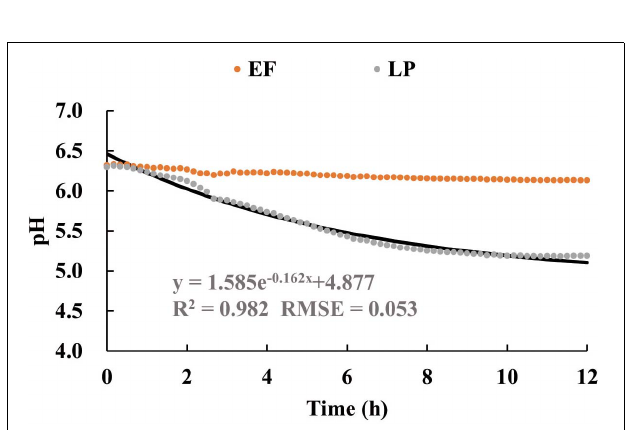
FIGURE 9 | The data decomposition of the time courses of pH in Figure 3A to separate the additional roles of Enterococcus faecium (EF) or Lactiplantibacillus plantarum (LP) to support LB in accelerating the acidification process of the substrate (MRS). The solid line is the regression approximation to the separate data of LP. EF, Enterococcus faecium ; LP, Lactiplantibacillus plantarum ; LB, Lentilactobacillus buchneri ; MRS, De Man, Rogosa, and